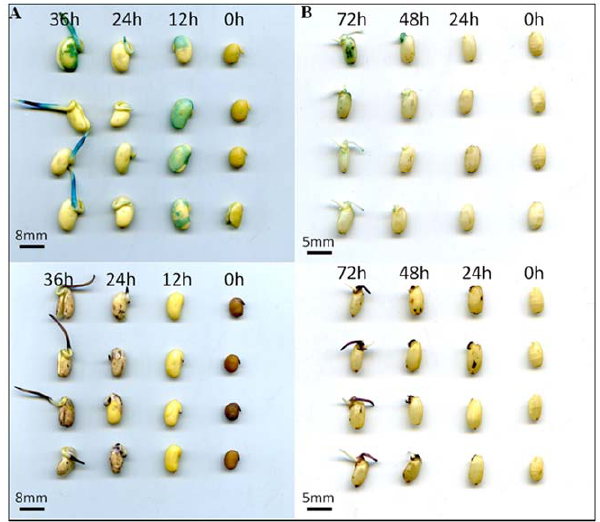
Figure 7. Accumulation of ROS in germinating crop seeds. (A) soybean; (B) rice. The upper panel shows the accumulation of H 2 O 2 with TMB staining, the bottom panel shows the accumulation of superoxide